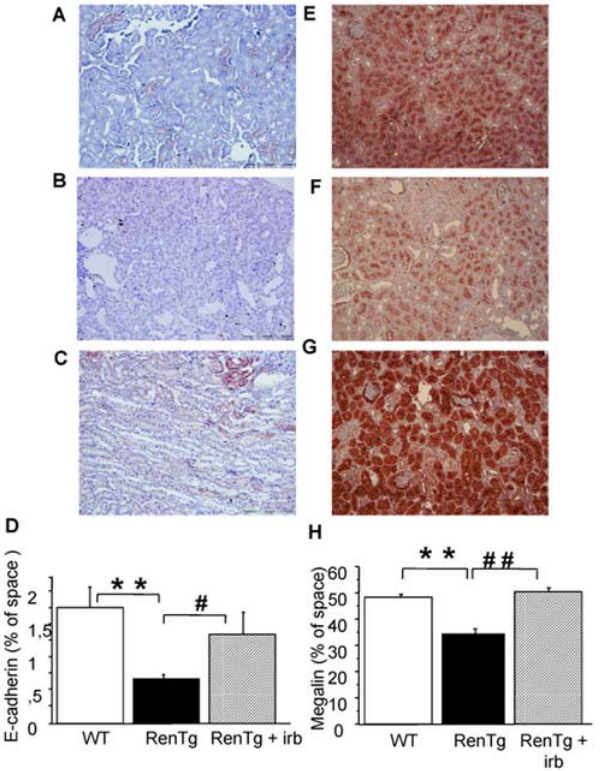
Figure 7. Therapy with AT1 receptor antagonist led to reappearance of proteins characterizing normal function of proximal tubules. Representative examples of the expression of proteins typical of the structure and function of proximal tubules such as E-cadherin and megalin. E-cadherin immunostaining in wild type (A) and RenTg mice before (B) and after (C) irbesartan treatment. Quantification by morphometric analysis is presented in D. Megalin expression in wild type (E) and RenTg mice before (F) and after (G) irbesartan treatment. Quantification by morphometric analysis is presented in H. Note that the blunted expression of both proteins in RenTg mice was increased to normal levels following treatment with the AT1 receptor antagonist. Bar=200 m m. Values are mean 6 SEM; n=5, 9 and 13 for wild type and RenTg mice before and after irbesartan, respectively; ** P , 0,01 vs WT; # P , 0,05 or ## P , 0,001 vs